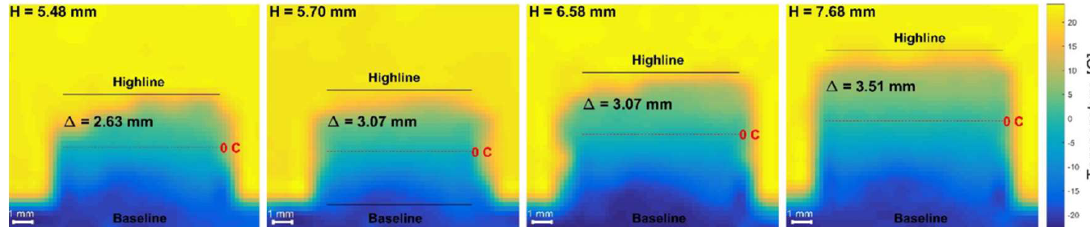
Figure 3. An example of the thermal imaging obtained while 3D printing layers of an XG:CNC (1:100) ink. The height (H) of the sample and the thickness of the top layer of liquid that had not yet been frozen (Δ) are indicated.